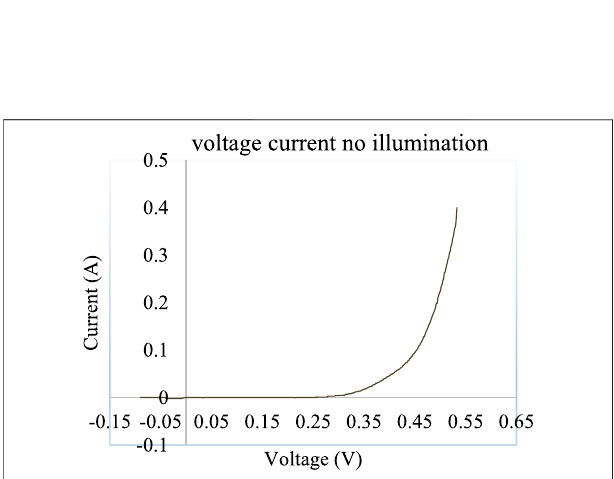
FIGURE 7 | IV characteristics of a 0.25 cm 2 n-p InGaAs cell were recorded in dark Tuley,